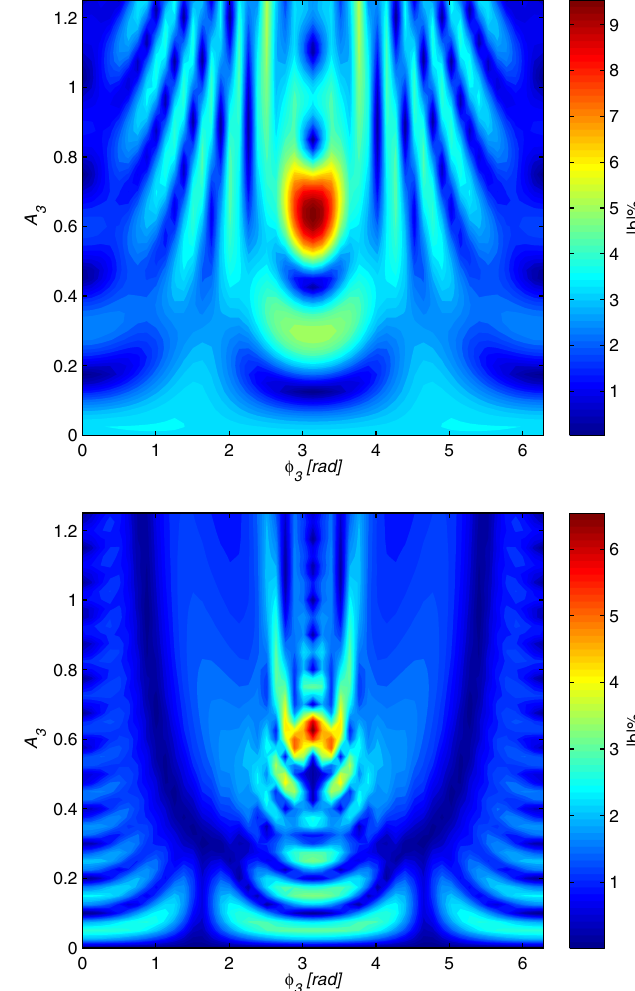
FIG. 11. Bunching factor tolerances of i-EEHG in third modulator for 50th harmonic (top) and 150th harmonic (bottom) using parameters given in Fig. 10.